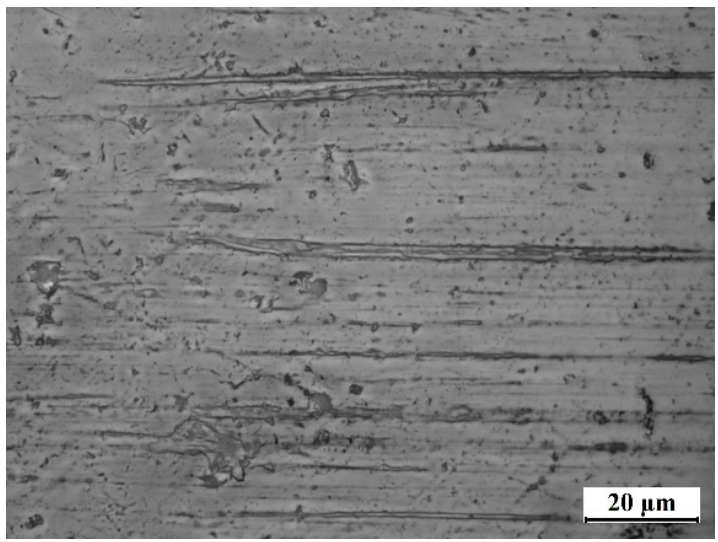
Figure 15. Abrasive wear of the modified die at the die angle of 59.0° observed by OEM.